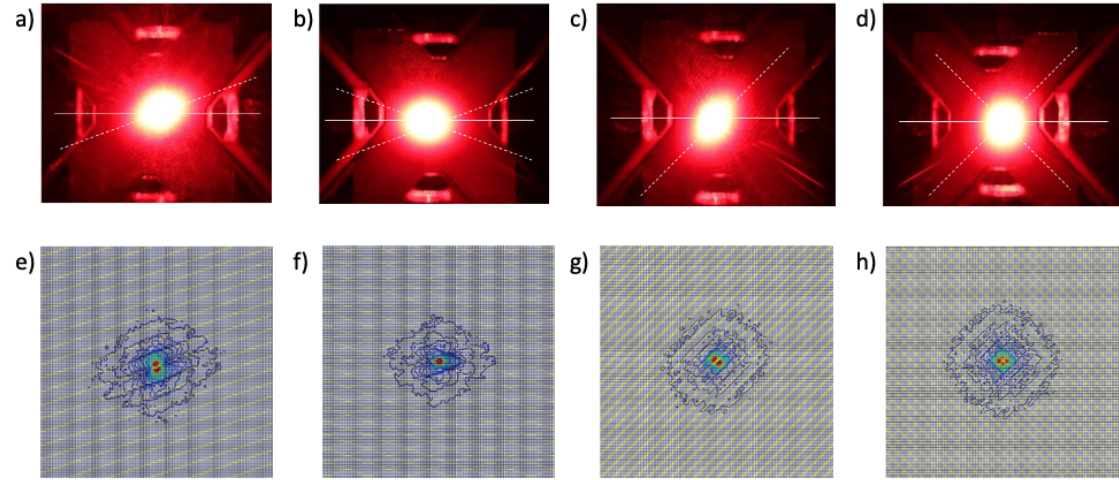
Figure 8. ( a – d ) SALS test and ( e – h ) isocurve fluence maps resulting from the numerical simulations for each 3D-printed fibrous sample: ( a , e ) α 1 = 20 ◦ , ( b , f ) α 1,2 = ± 20 ◦ , ( c , g ) α 1,2 = 45 ◦ and ( d , h ) α 1,2 = ± 45 ◦ .